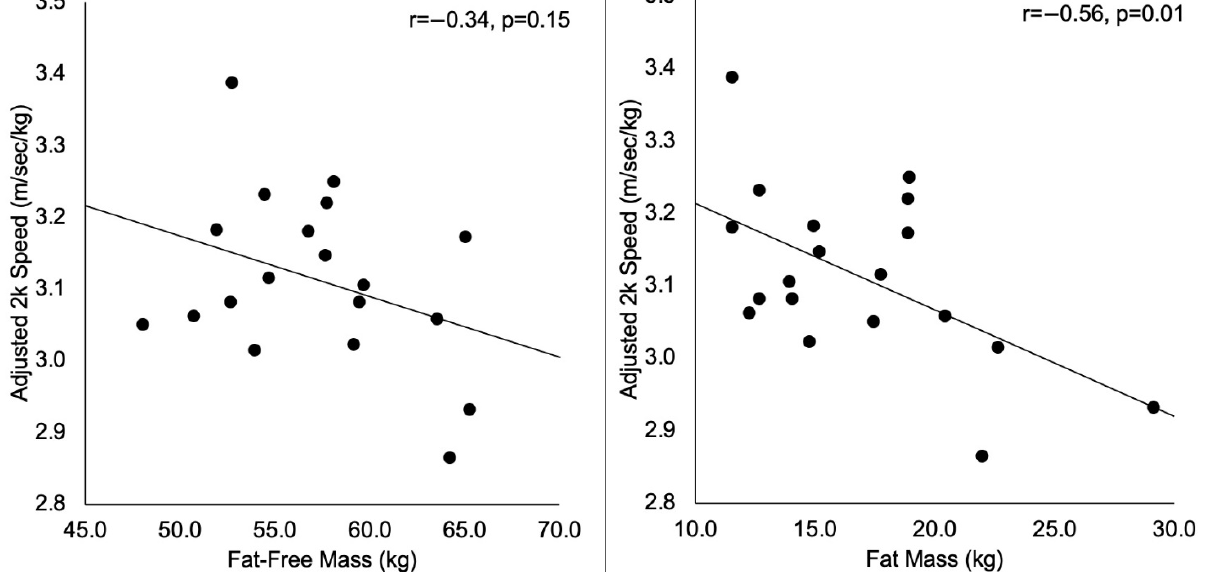
Figure 3. Scatterplots representing the relationships between adjusted 2 km (2k) speed and the body composition metrics.